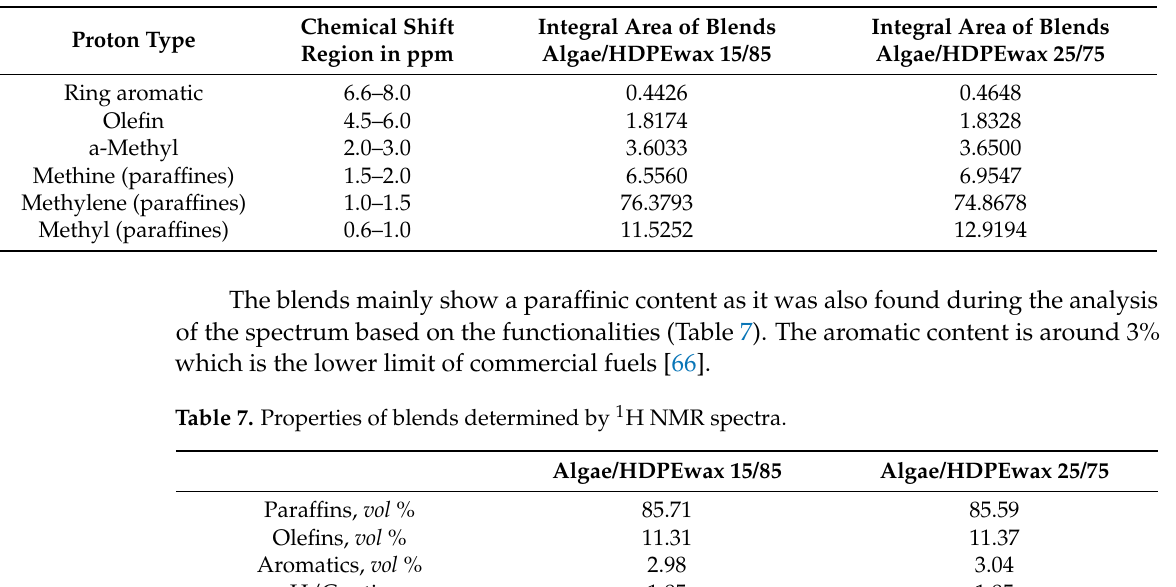
Table 6. NMR spectral region and integral area of the two blends Algae/HDPEwax 15/85 and 25/75.